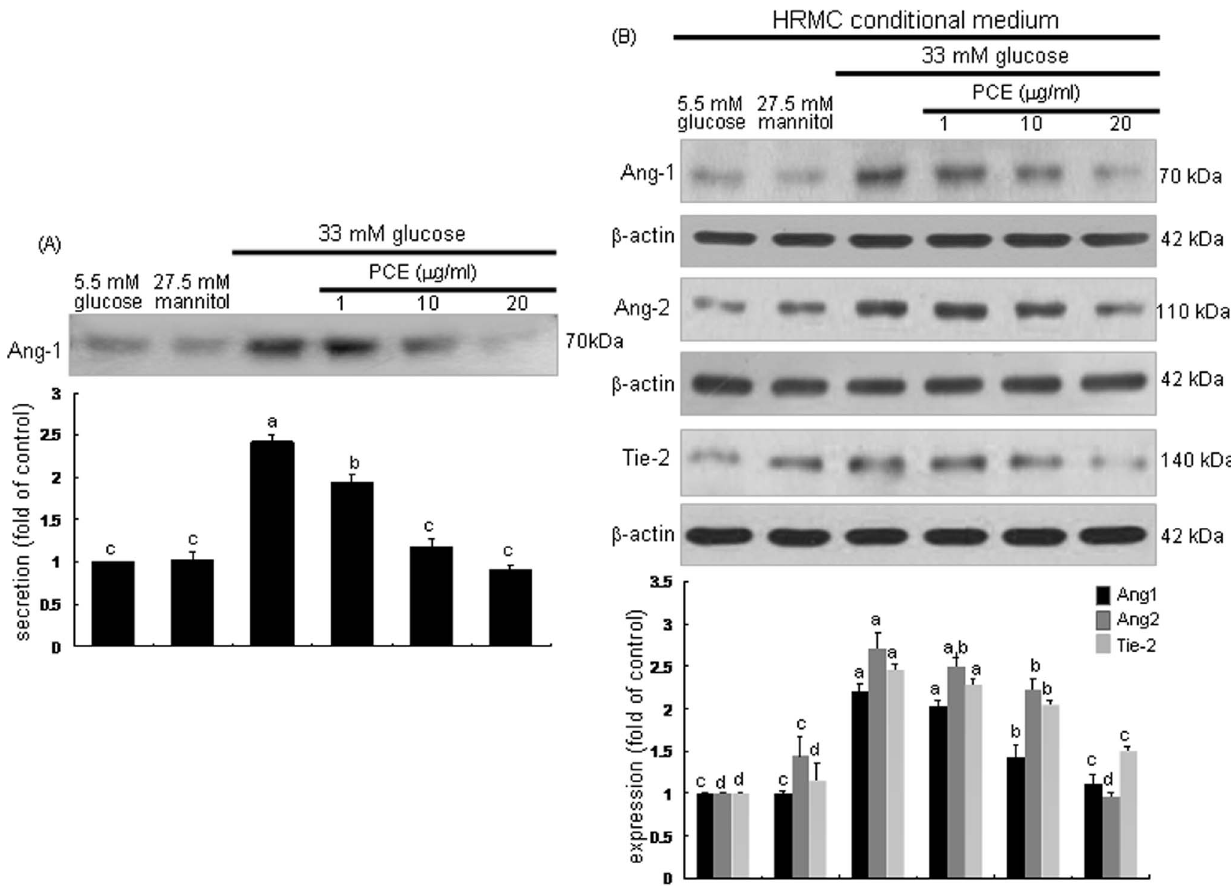
Figure 6. Western blot analysis showing inhibition of diabetic induction of Angpt1, Angpt2 and Tie-2 by PCE. HRMC were incubated in 5.5 mM glucose and plus 27.5 mM mannitol for osmotic control or 33 mM glucose (A). HUVEC were incubated in HRMC conditioned media [with (w/) 27.5 mM mannitol and w/33 mM glucose] for 6 h in the absence and presence of 1–20 m g/ml PCE (B). Cell lysates were subjected to Western blot analysis with a primary antibody of Angpt1, Angpt2 and Tie-2. b -Actin protein was used as an internal control. The bar graphs (mean 6 SEM, n=3) in the bottom panels represent quantitative results obtained from a densitometer. Respective values not sharing a common letter differ, P , 0.05.